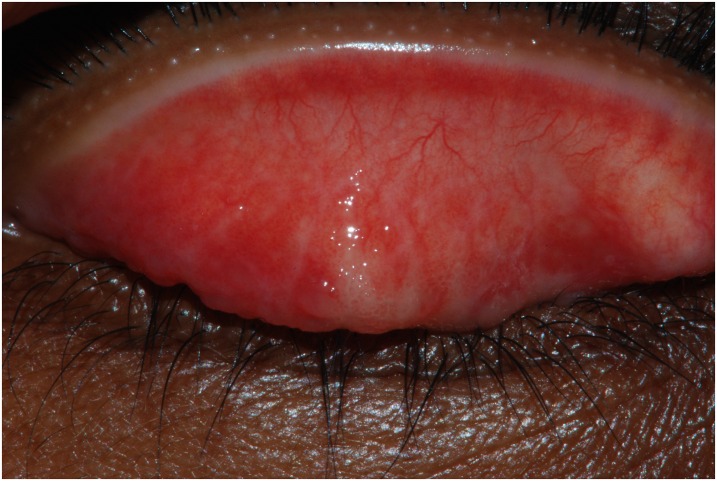
Conjunctival photograph of the individual felt to demonstrate equivocal evidence of conjunctival scar, Western Division, Fiji, 2015.